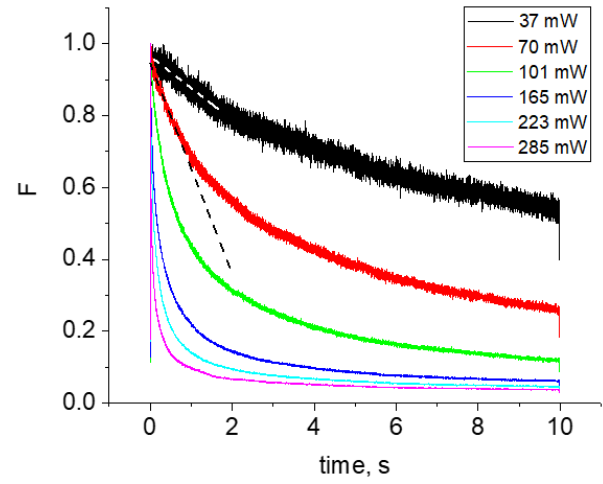
Figure 3. Fluorescence decay kinetic curves obtained at λ = 800 nm at different power values at the sample, shown in the inset. The kinetics are normalized to the F (0) = 1 values. The dashed lines illustrate the derivatives of the decay curves at t = 0, corresponding to 37 and 70 mW.